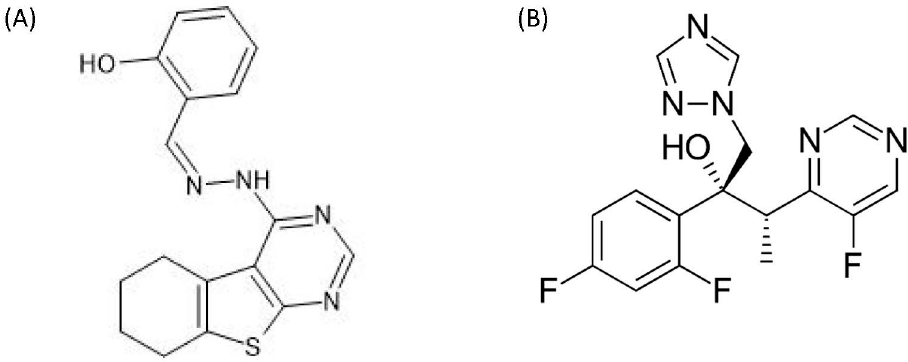
Figure 1. Chemical structure of ( A ) OJT007; ( B ) voriconazole (Internal Standard).